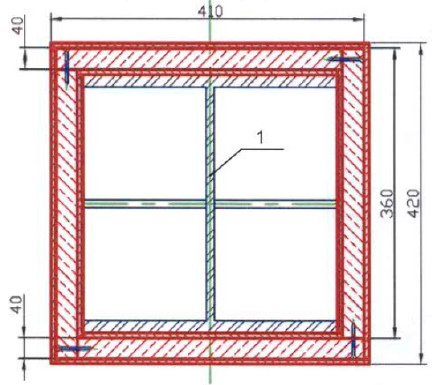
Figure 5. Test specimen design.